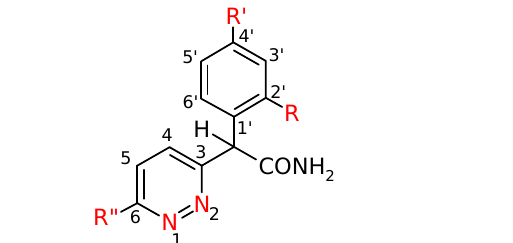
Figure 3 . Numbering system for compounds 3a-f, 3h, 3f ′ , 3g ′